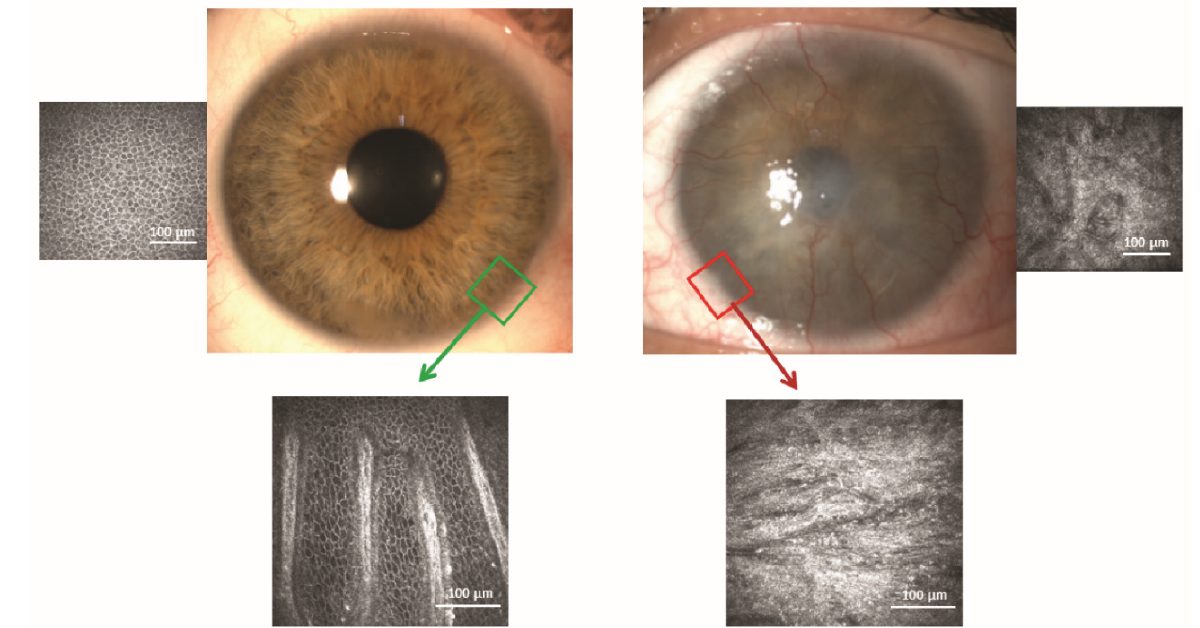
Figure 2. ( Top Left ) Location of the limbal niche ( green box ) in the normal eye of a 26-year-old man. ( Lower Left ) Confocal image of the limbal niche that is responsible for maintaining the corneal epithelial phenotype. ( Top Right ) The left eye of the man suffered a chemical injury 2 years before. The injury destroyed his limbal niche ( red box ). Consequently, the corneal epithelium has a conjunctival phenotype derived from the adjacent conjunctiva. ( Lower Right ) Confocal image of the damaged limbal niche.